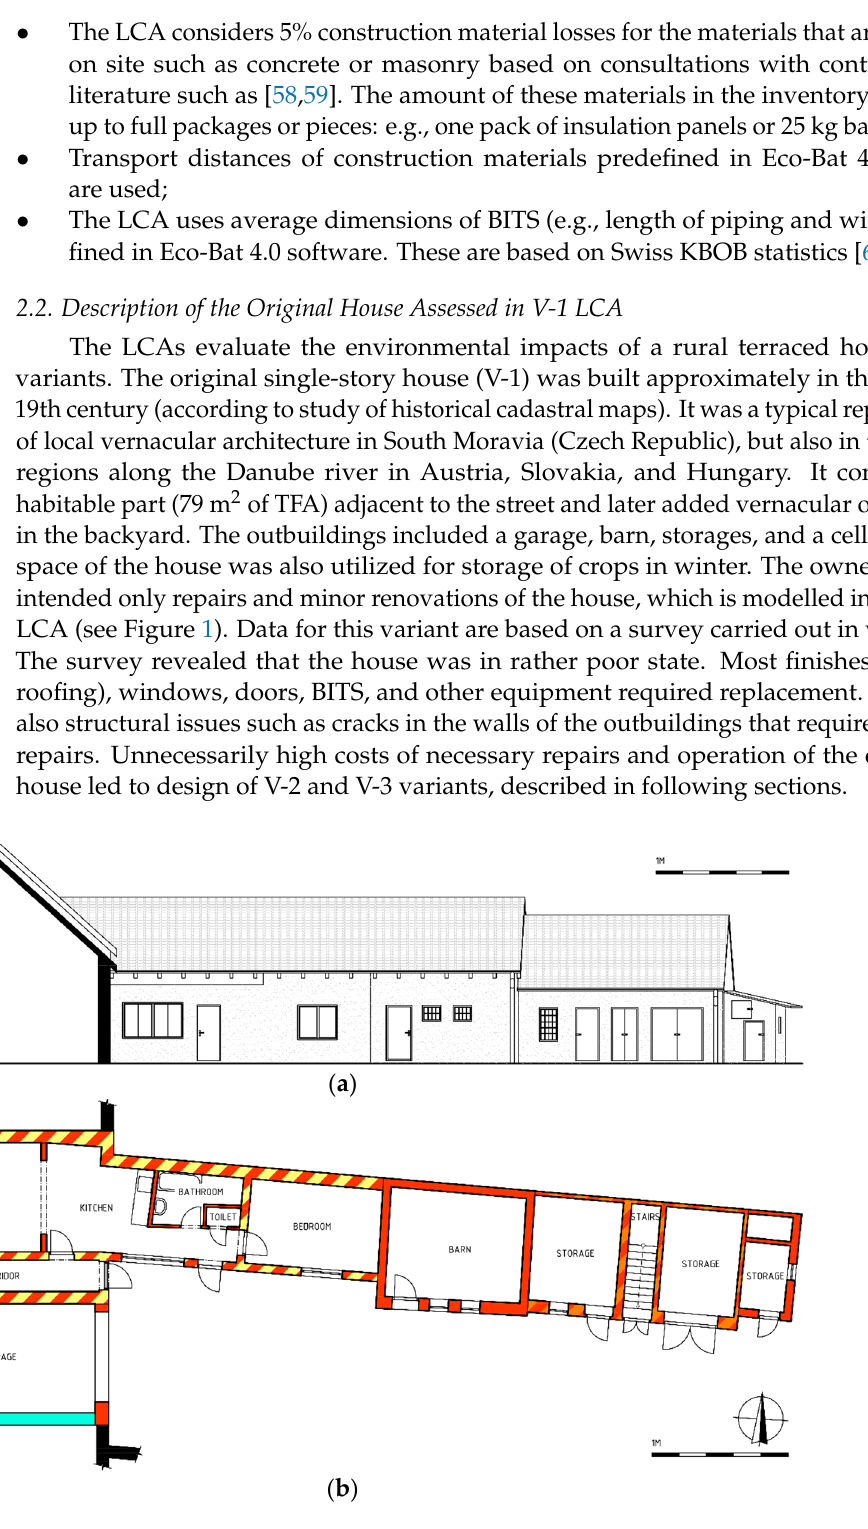
Figure 1. Original terraced house evaluated in V-1 LCA: ( a ) southern elevation with black hatching indicating envelope of adjacent house; ( b ) ground floor plan with coloured hatching indicating different construction materials identified during surveys. Black = envelope walls of adjacent houses, red = solid fired ceramic bricks, blue = aerated concrete blocks, red-yellow stripes = mix of solid fired bricks and adobe bricks, red-orange stripes = mix of solid fired bricks and hollow ceramic